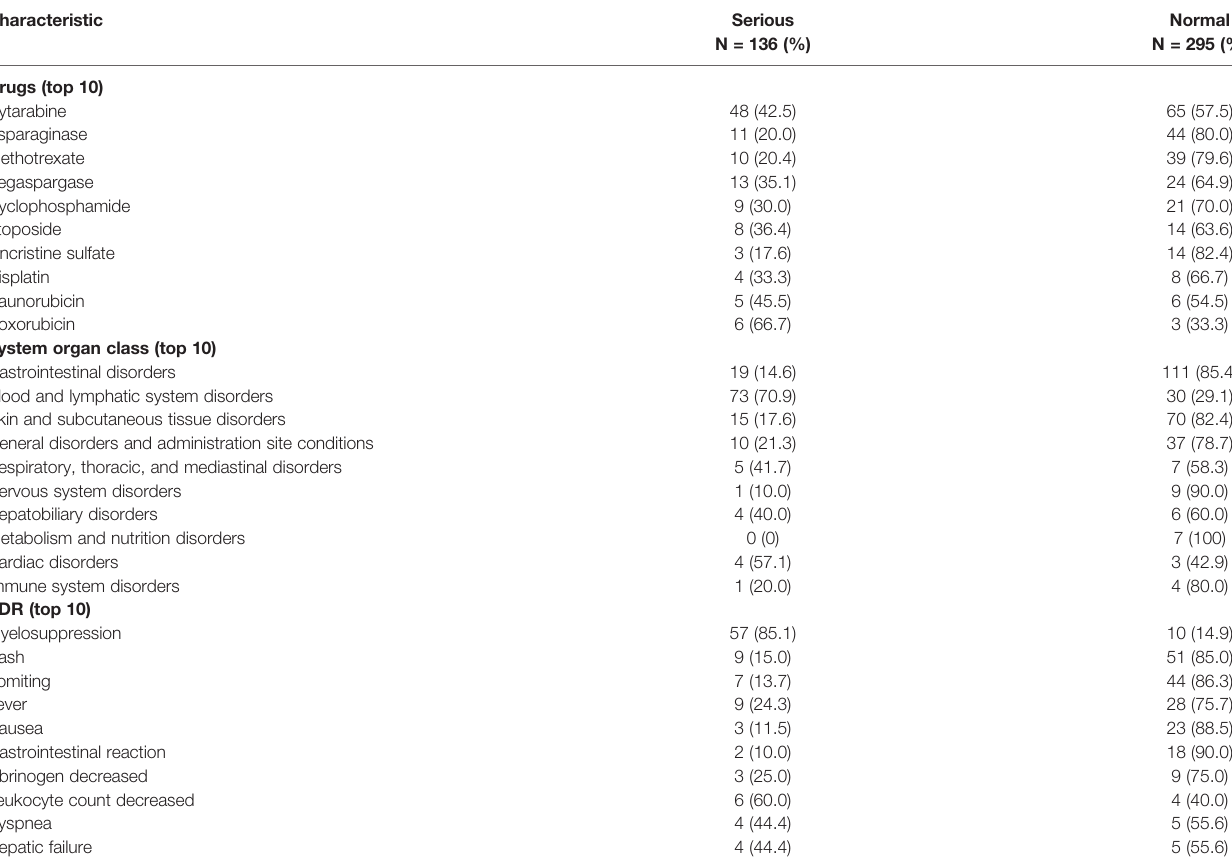
TABLE 4 | The characteristics of ADRs aspect by the